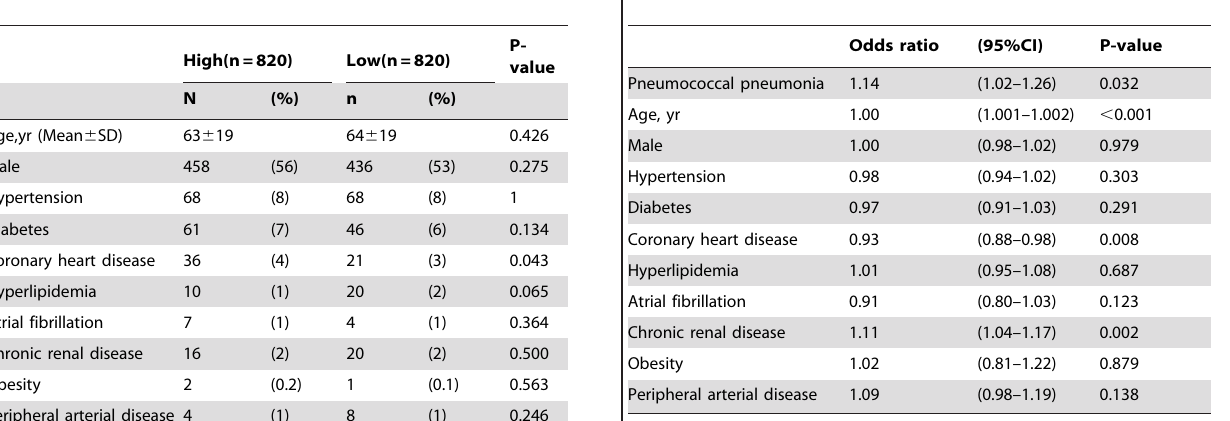
between the pneumococcal pneumonia and stroke for the two-year follow–up period.